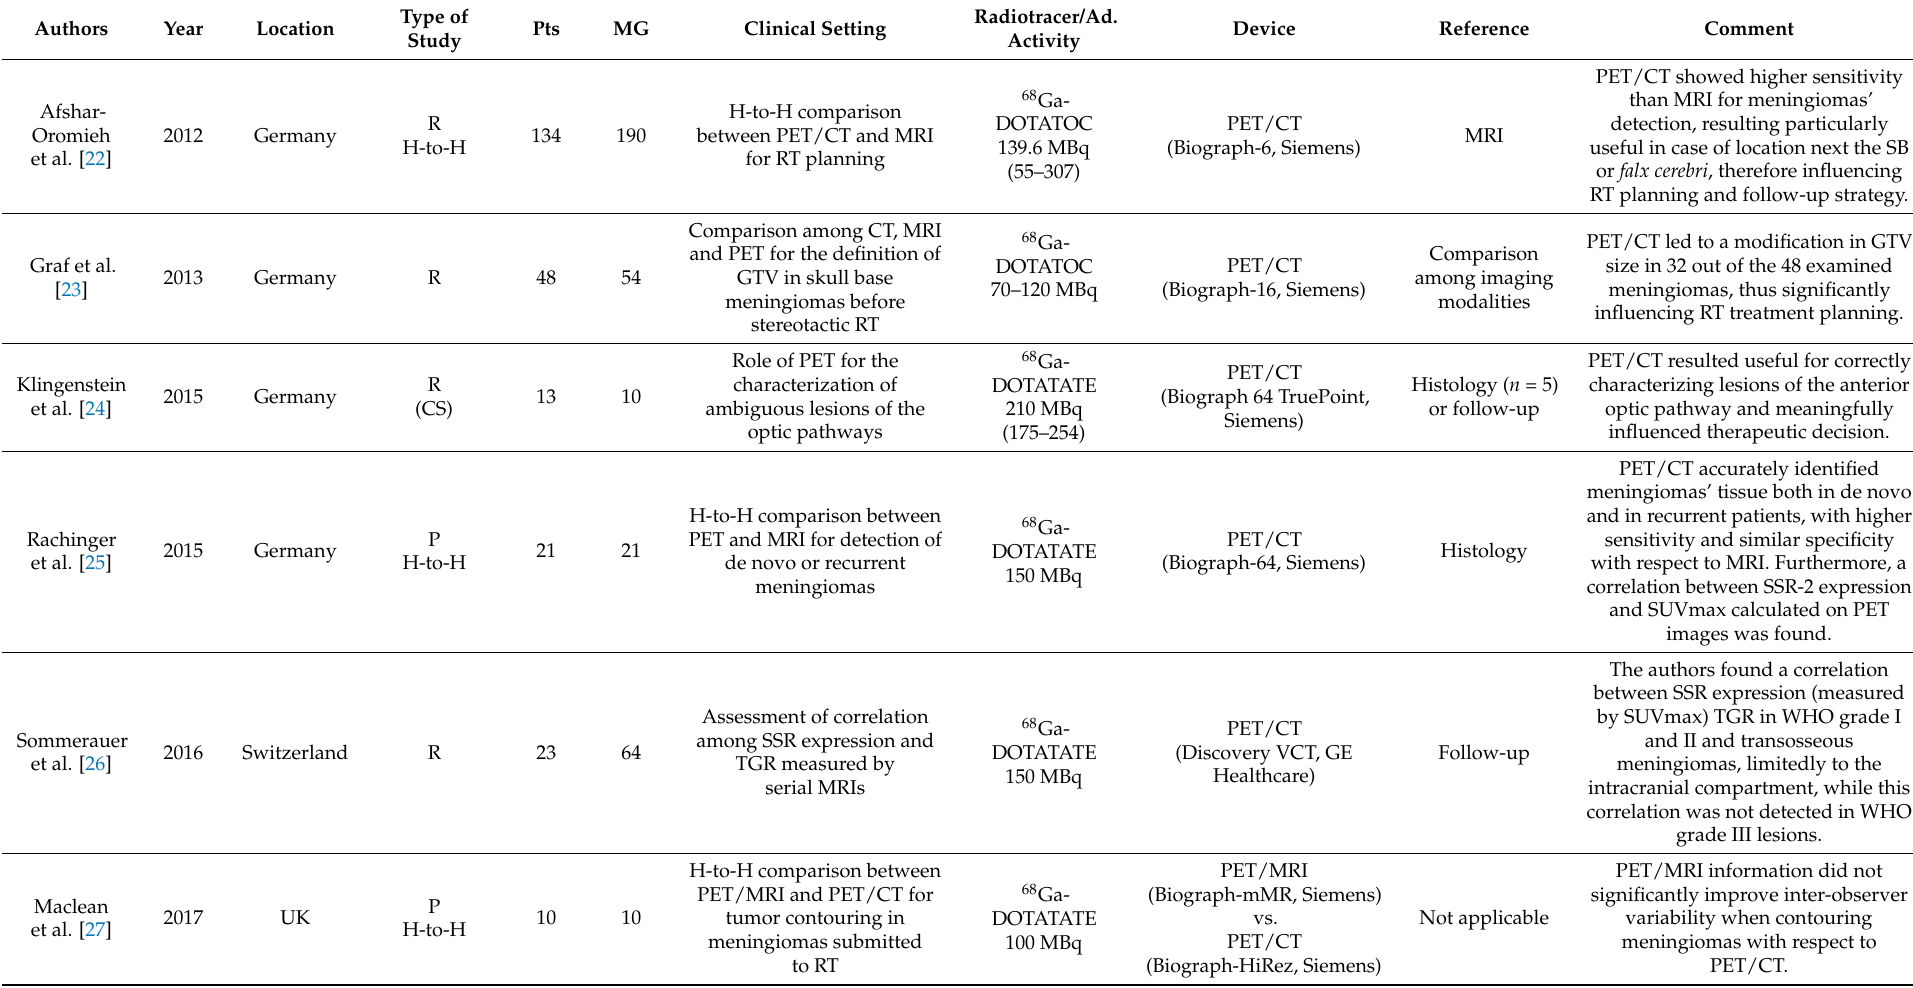
Table 1. Analyzed manuscripts on the applications of SSR-targeted PET imaging in